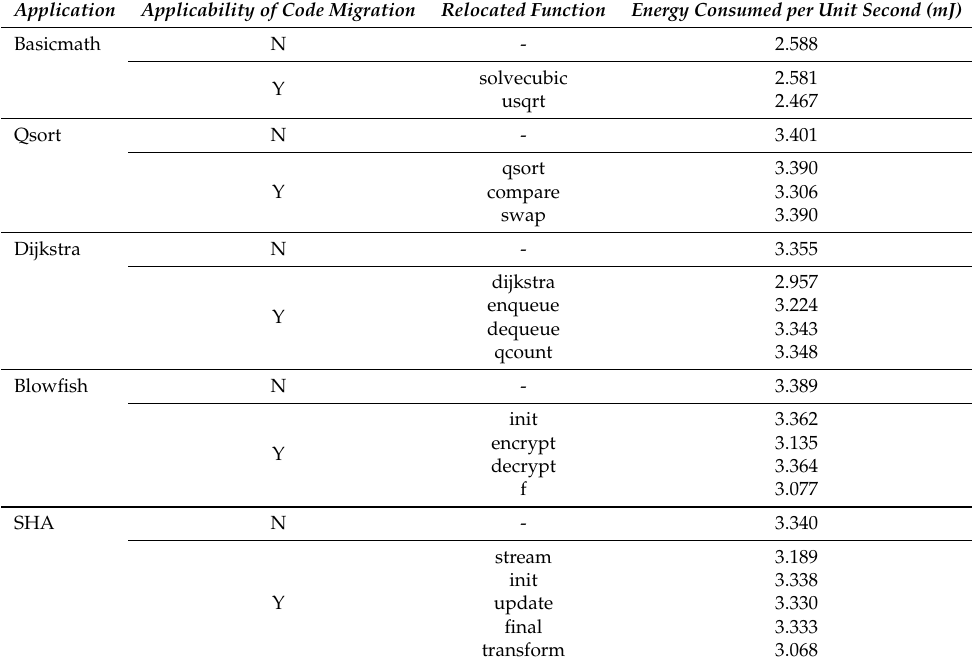
Table 5. Energy consumed per unit second of benchmark functions.